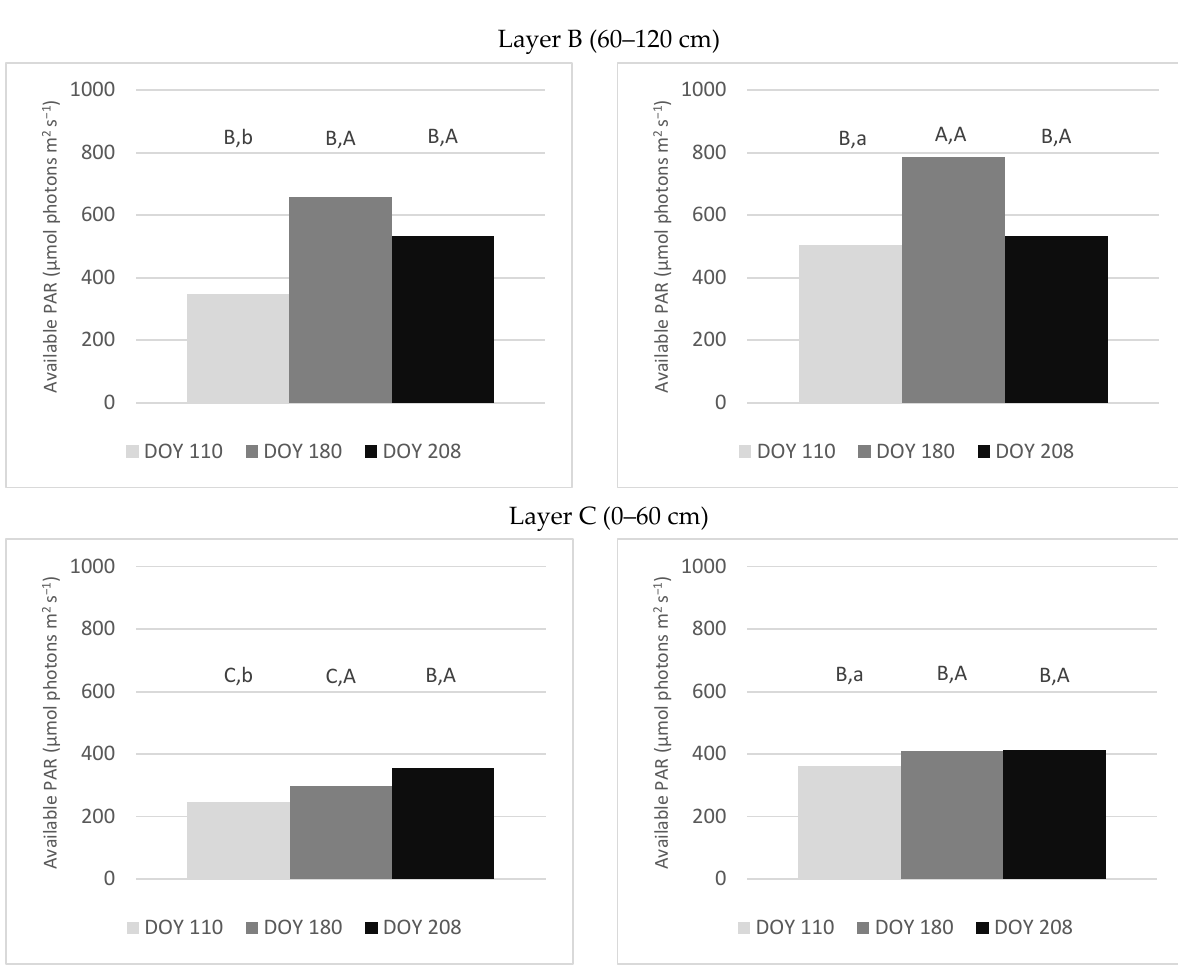
Figure 2. Available PAR (μmol photons m 2 s − 1 ) in relation to layer (layers A, B and C) on east and west sides of orchard with north-south orientation on three DOYs. The first letter denotes significant differences between layers for a given exposure and DOY ( n = 45; p = 0.05/0.01; SNK test); the second letter denotes significant differences between exposure for a given layer and DOY ( n = 90; p = 0.05/0.01; SNK test). Lower case letters denote statistical differences with p = 0.05. Capital letters denote statistical differences with p = 0.01.